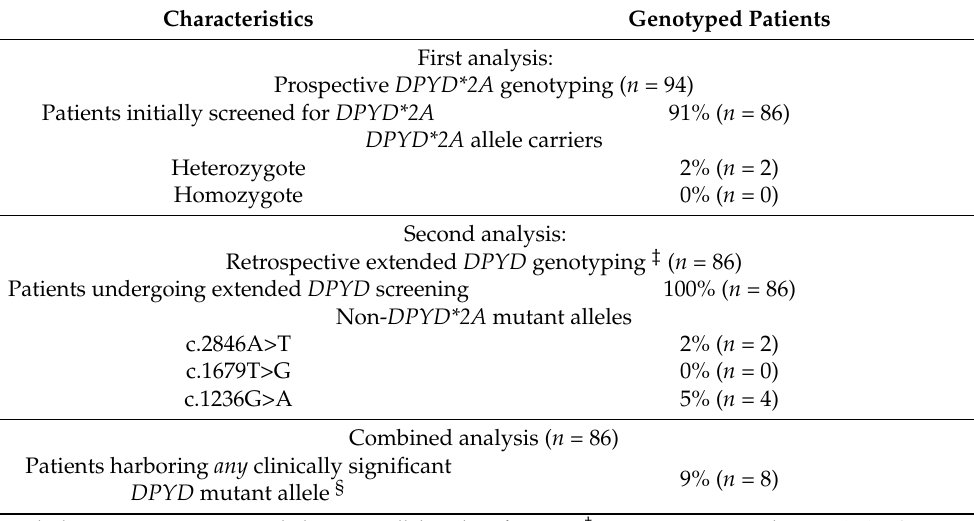
Table 2. DPYD genotyping †